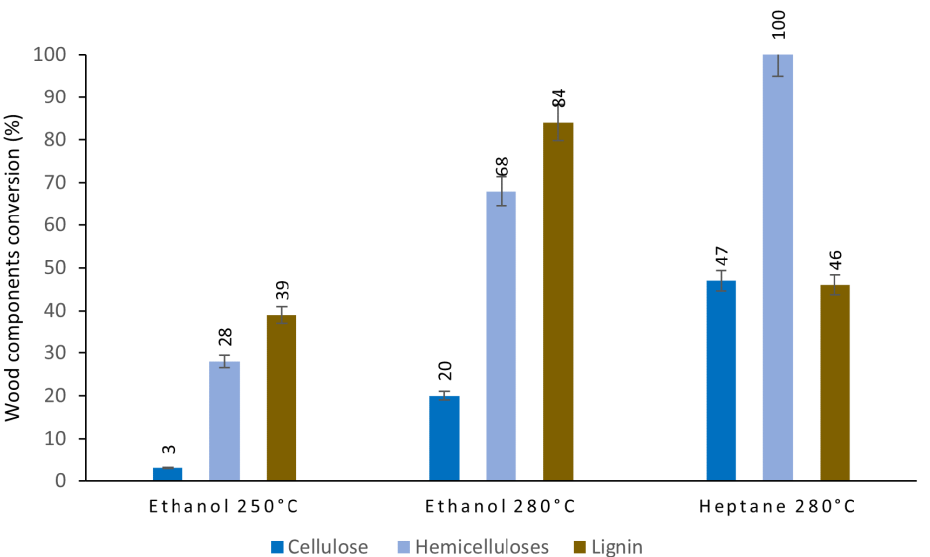
Figure 1. Wood components’ conversion (wt%) in SC ethanol at 250 °C and 280 °C and in SC n- heptane at 280 °C. Conditions: Batch reactor. m pine wood = 2.5 g, m solvent = 27 g, 1 h at 250 °C or 280 °C in SC ethanol, 1 h at 280 °C in SC n-heptane.